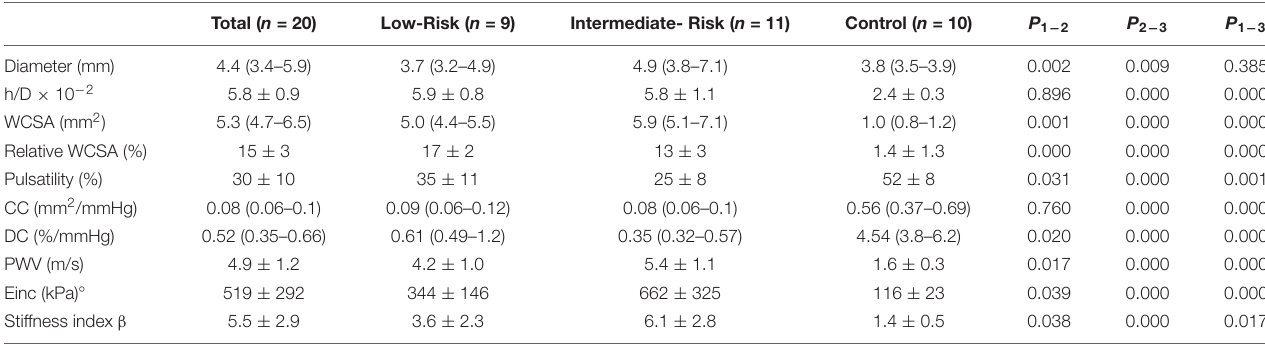
TABLE 3 | Pulmonary arterial geometric (structural) and stiffness (functional)